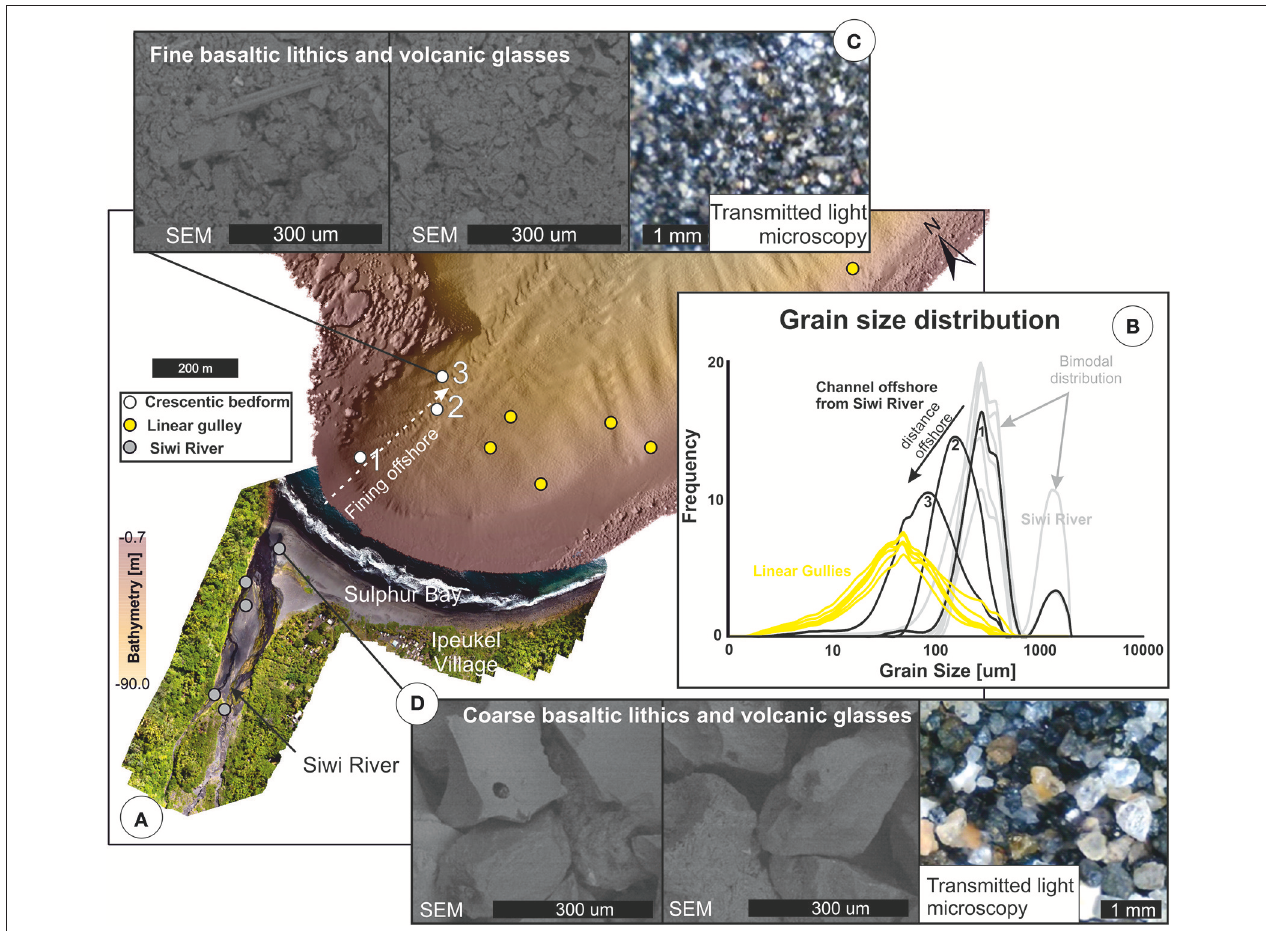
FIGURE 7 | Location of sediment samples presented in this study (A) overlain on drone-acquired photographic survey of Siwi River and multibeam bathymetry offshore. Grain size distributions (B) from Siwi River (gray lines) are similar to those from the proximal part of the sinuous channel with crescentic bedforms (black lines – 1–3), but distinct from samples from linear gullies (yellow lines). Details of SEM and transmitted light microscopy are shown for specific locations (C,D)